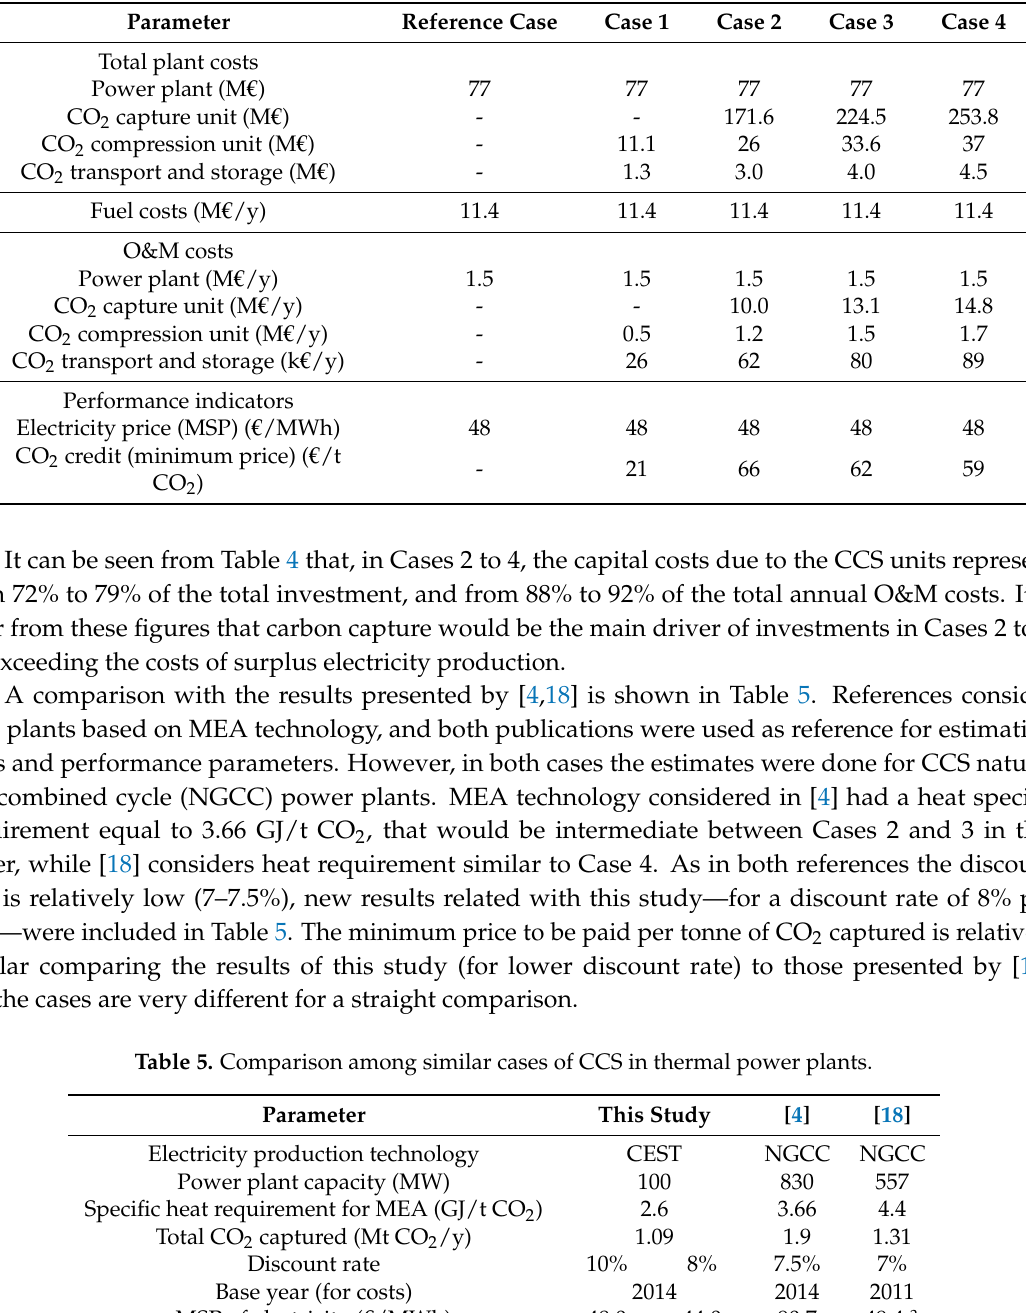
Table 4. Costs and economic performance indicators for the BECCS systems.